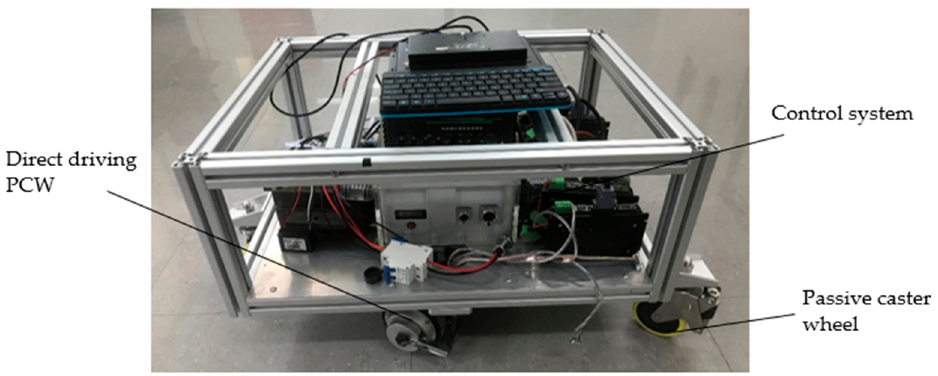
Figure 2. Prototype of the omnidirectional mobile robot (OMR) with PCWs.